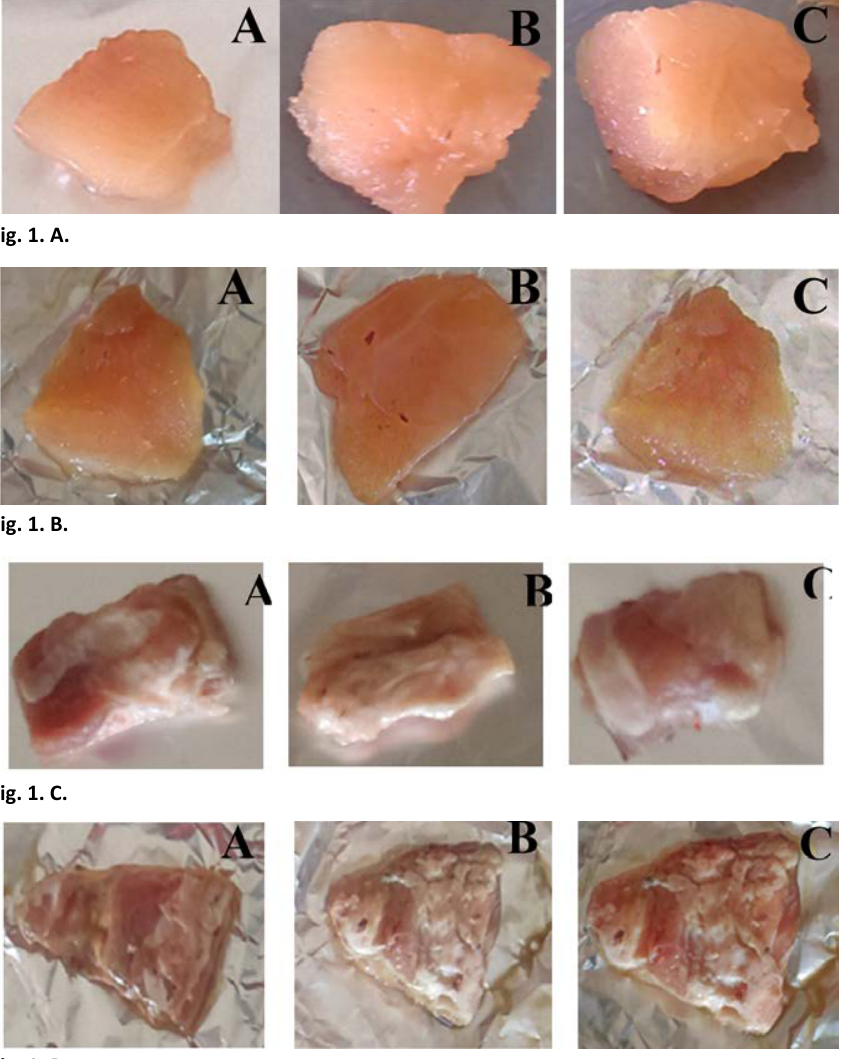
Fig.1. A 0 th of chiken meat sample, B. 4 th day of chiken meat sample, C. 0 th day of Mutton meat sample, 4 th day of Mutton meat sample. Note: A. Control, B. Treated with culture and C. Treated with